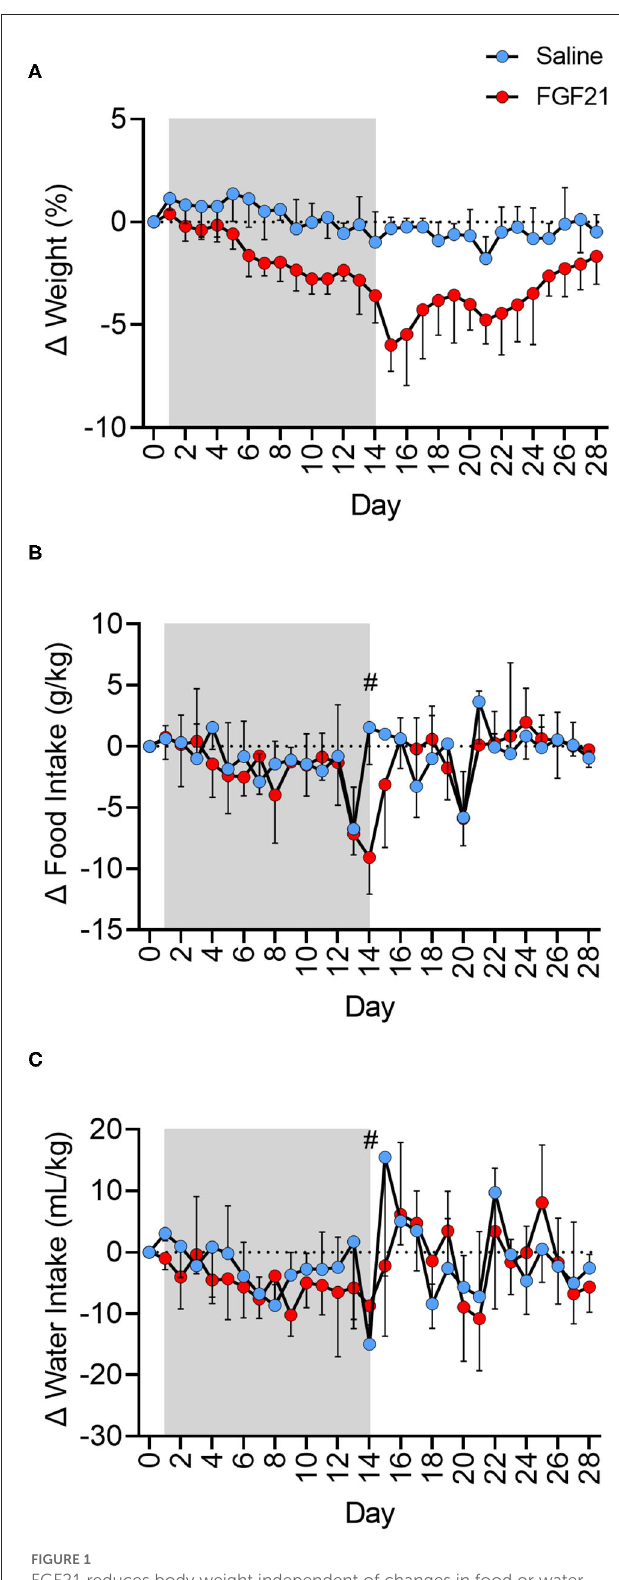
FIGURE1 FGF21 reduces body weight independent of changes in food or water intake. (A) Treatment with FGF21 resulted in a significant decrease in body weight at a rate 2.54 times faster than in saline-treated cats. On day 15, FGF21-treated cats had a 5.93% decrease in body weight, with only a 0.28% decrease in body weight in saline-treated cats. Discontinuation of FGF21 resulted in a rapid regain of weight. (B)